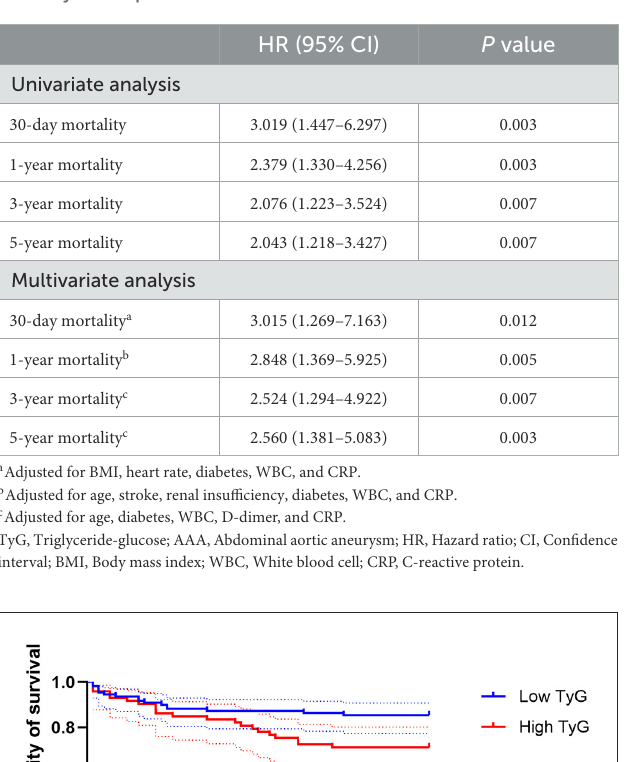
TABLE 2 The association between the TyG index and postoperative mortality of AAA patients.